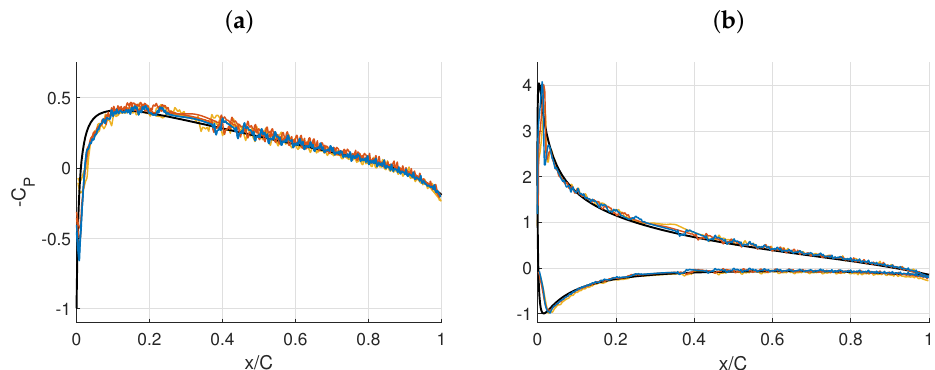
Figure 7. Pressure coefficients (plotted as − C P ) along a NACA-0012 foil upper and lower boundaries, calculated with the LBM-LES model for Re = 1.44 × 10 6 with a Grid 3 resolution (Table 1): ∆ x / C = (—) 3.5 × 10 − 3 , (—), 3.0 × 10 − 3 , and (—) 2.5 × 10 − 3 , at angles of attack: ( a ) θ = 0 ◦ and ( b ) 8 ◦ , compared to (—) Xfoil